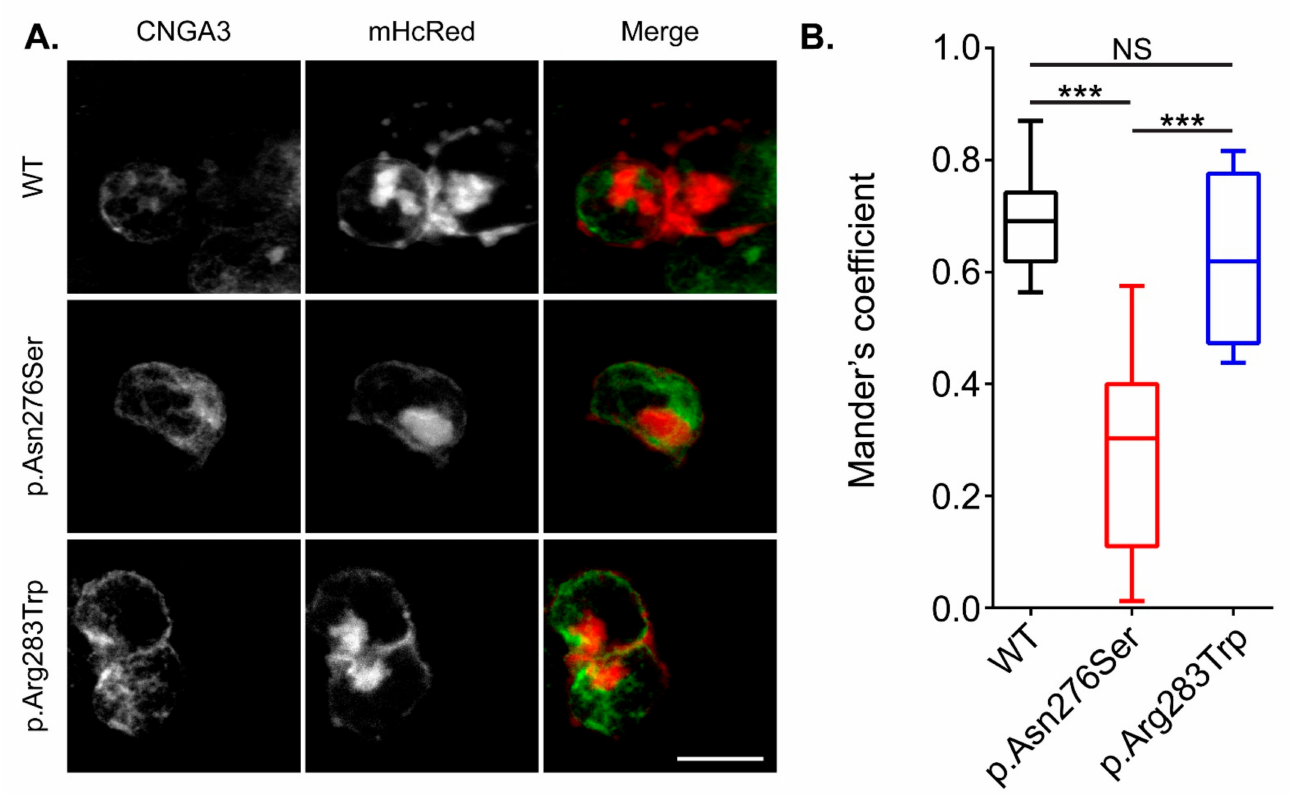
Figure 5. ( A ) Surface expression study of wild type (WT) and mutant CNGA3 protein. CNGA3 is labeled in green; however, mHcRed (red) is used to mark plasma membrane. ( B ) Graphical representation of Manders’ coefficient used to quantify colocalization of green and red fluorescence at the plasma membrane in 20 transfected cells per construct (*** p < 0.001). NS, not